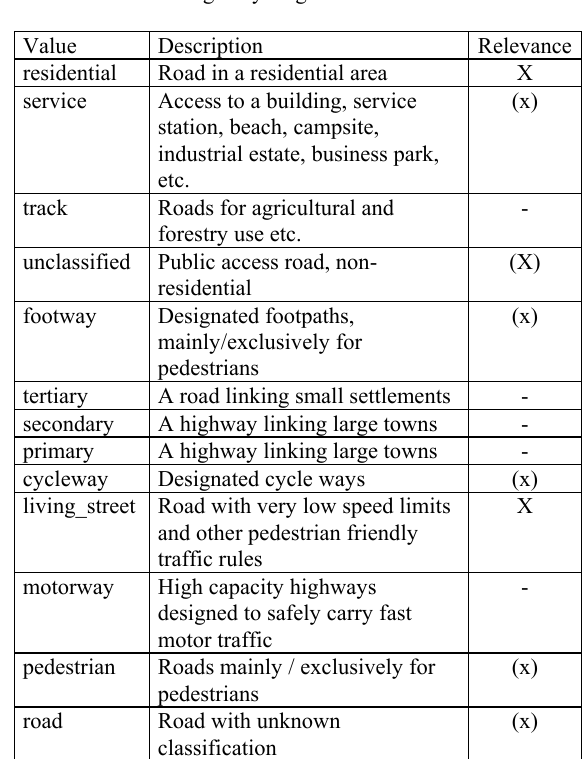
Figure 3. OSM built-up features and buildings for a part of Darwin, Australia (light orange = “residential”, violet = “industrial”, dark red = “buildings”) 3.4 Roads in OpenStreetMap Roads are the third source of build-up areas. At first sight, this may be a surprising statement. However, special types of roads allow deriving information about the surroundings. For example, residential houses are typically built along residential roads. Roads in OpenStreetMap are (mostly way) elements with a “highway” tag (OSM Wiki, 2016). The corresponding value classifies the road. Table 2 lists and describes selected, often used values of the “highway” tag.